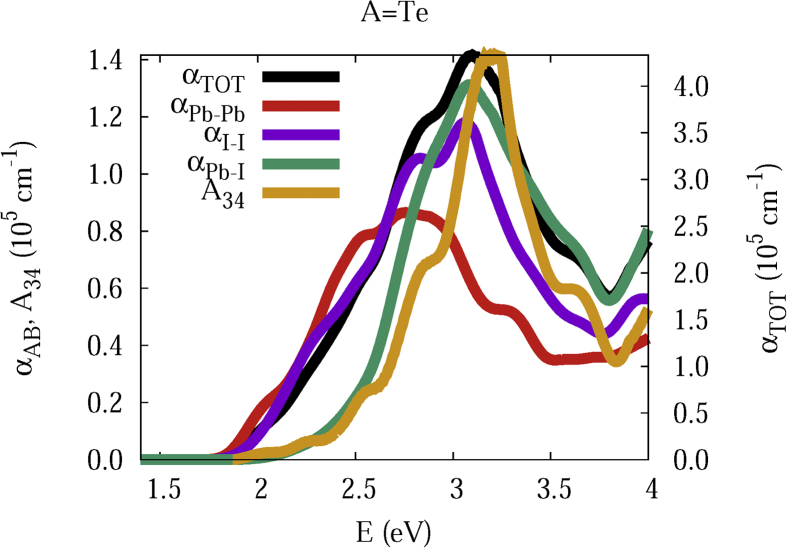
Same legend as that in Fig. 1, but for A = Te.